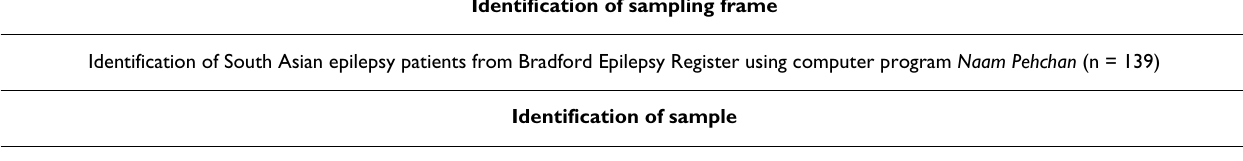
Table 2: Process of recruiting people with epilepsy